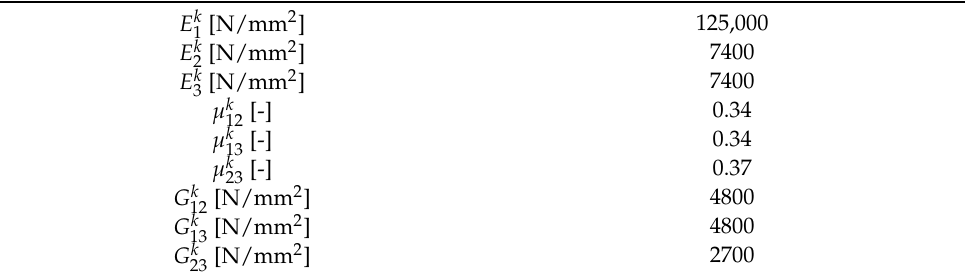
Table 4. Example 3: Material